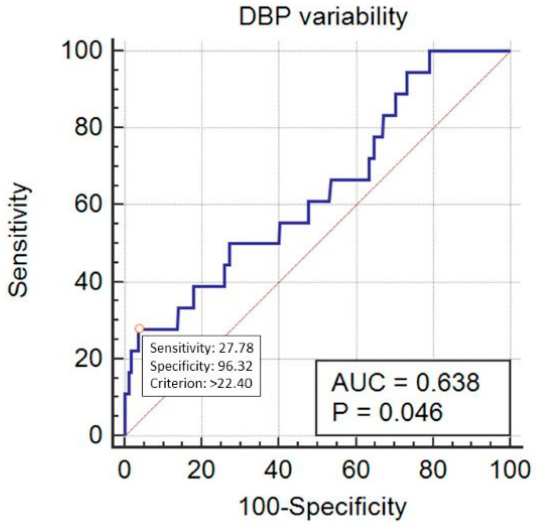
Figure 6. Prediction of mortality by the diastolic blood pressure (DBP) variability (expressed as DBP_Cv in %).